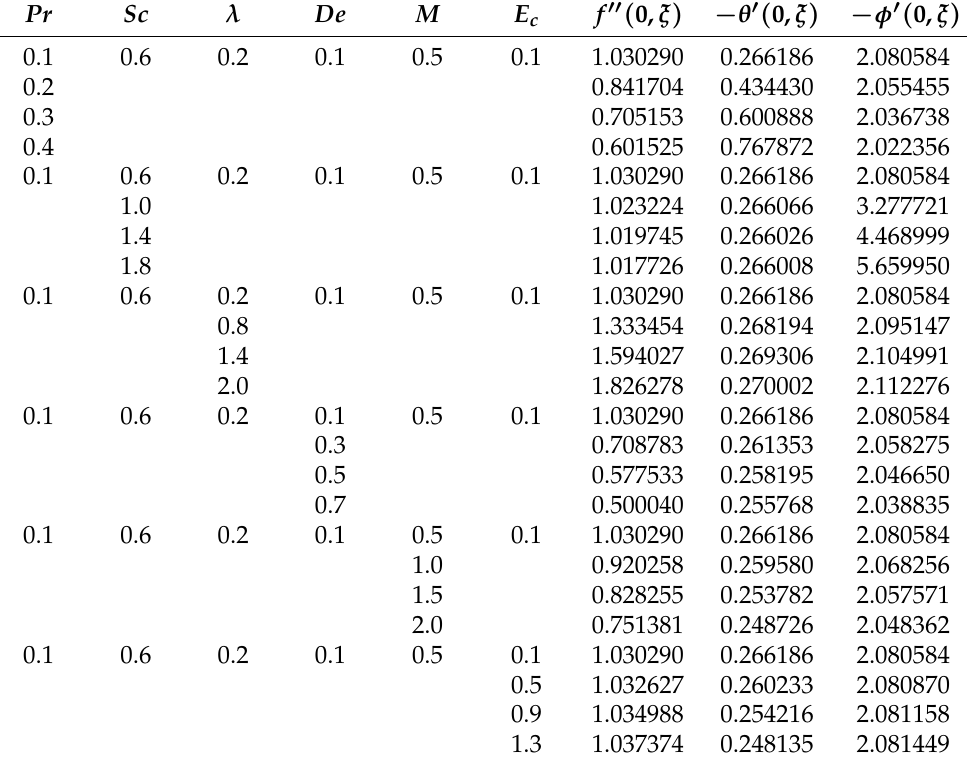
Table 1. Computed values of the skin friction coefficient, local Nusselt number and local Sherwood number for different values of Pr , Sc , De , M and Ec when ∆ = 0.1, K = 0.1, R = 0.5, γ = 0.5, ξ =